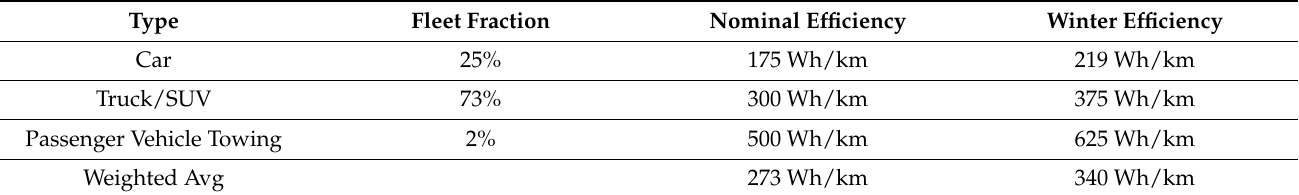
Table 1. EV fleet breakdown and